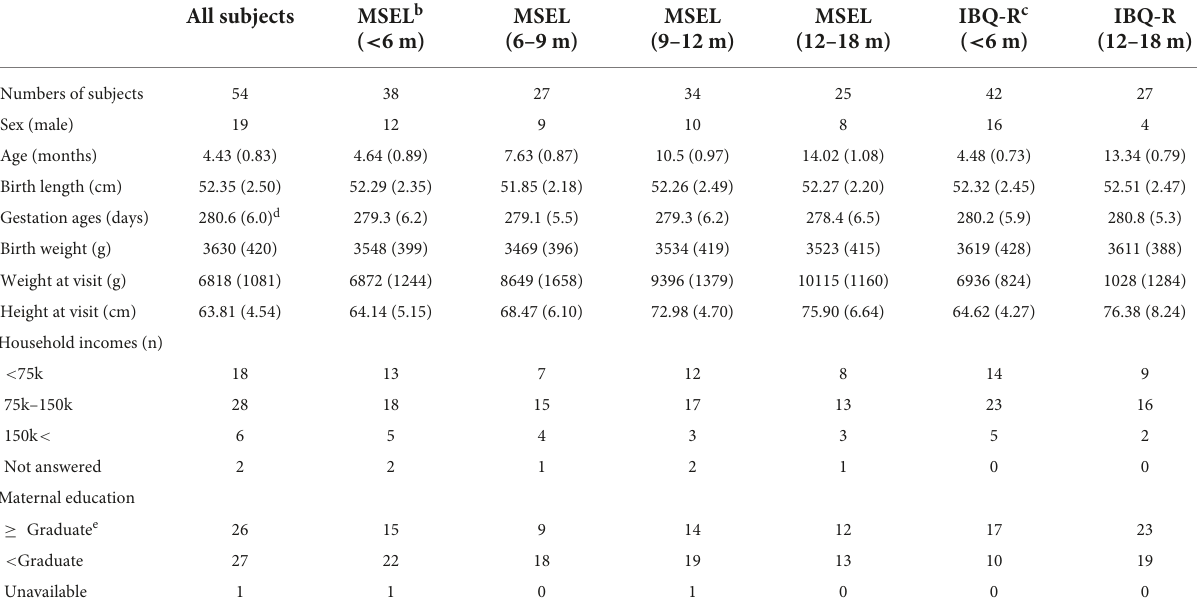
TABLE 1 Characteristics of the participants.